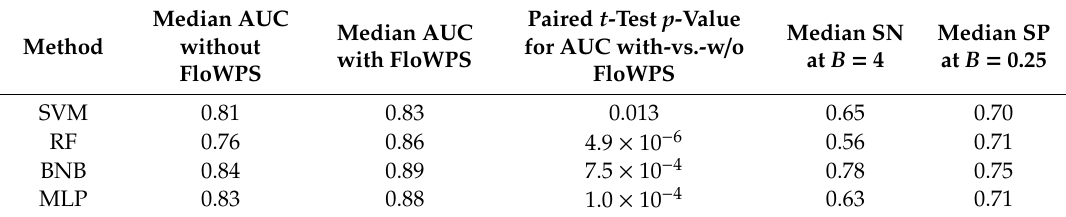
Table 3. Performance metrics for BNB, MLP, RF and SVM methods with the advanced settings for eleven datasets with variable numbers of responders and non-responder samples.